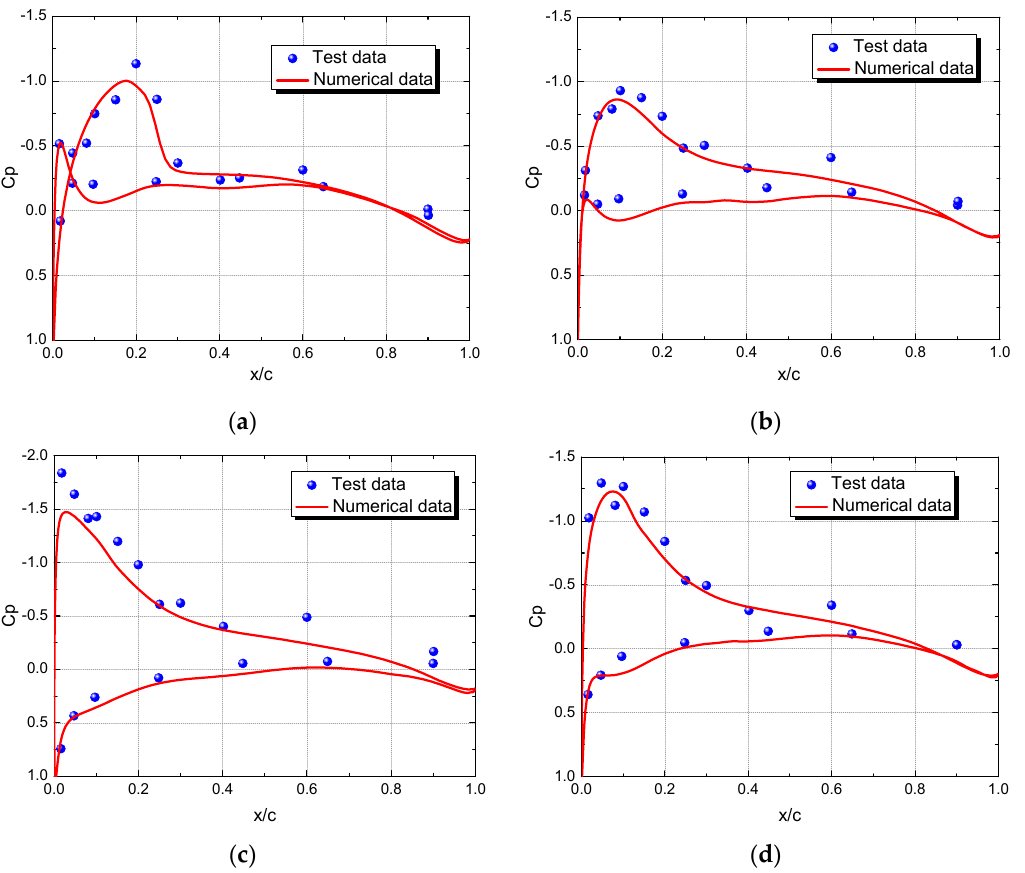
Figure 7. Comparison of Cp between the test data and numerical data. ( a ) ψ = 90°. ( b ) ψ = 180°. ( c ) ψ = 270°. ( d ) ψ = 360°.